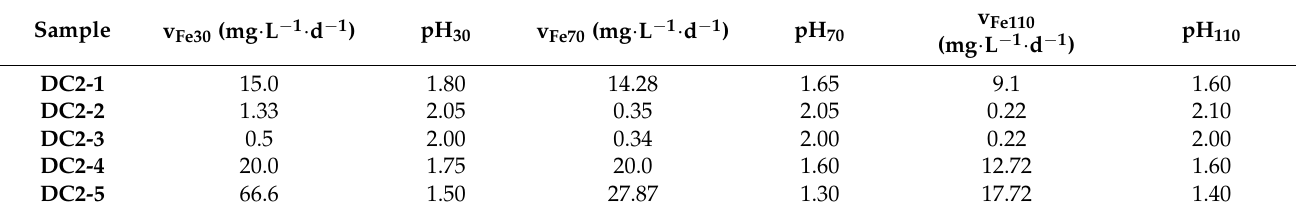
Table 4. Main parameters of the biooxidation of DC2